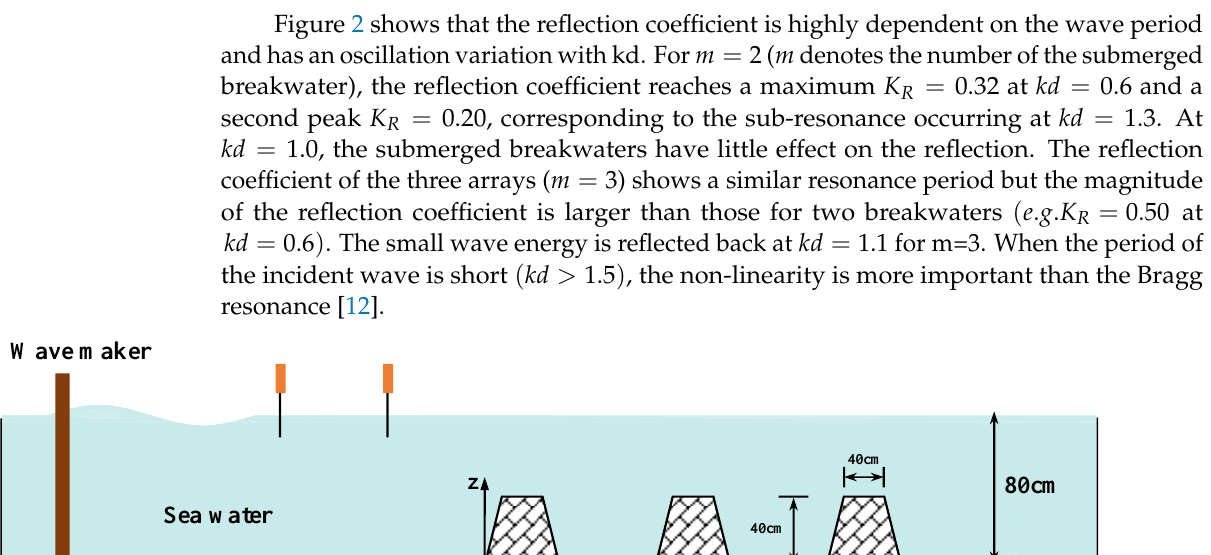
Figure 1. Cho et al. (2004)’s experiment for the wave reflection by the submerged breakwaters.